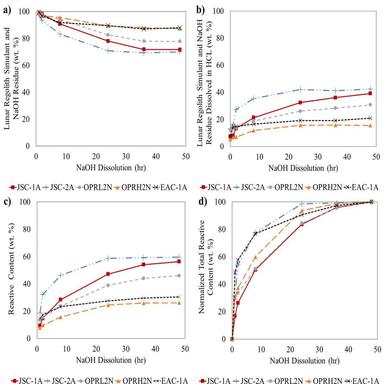
a) The lunar regolith simulant and sodium hydroxide residue weight percent to the original weight of the lunar regolith simulant used and b) The weight percent of the lunar regolith simulant and sodium hydroxide residue dissolved in hydrochloric acid to the original lunar regolith simulant and sodium hydroxide residue amount. c) the reactive content and d) normalize reactive content as a function of time for each of the lunar regolith simulants.